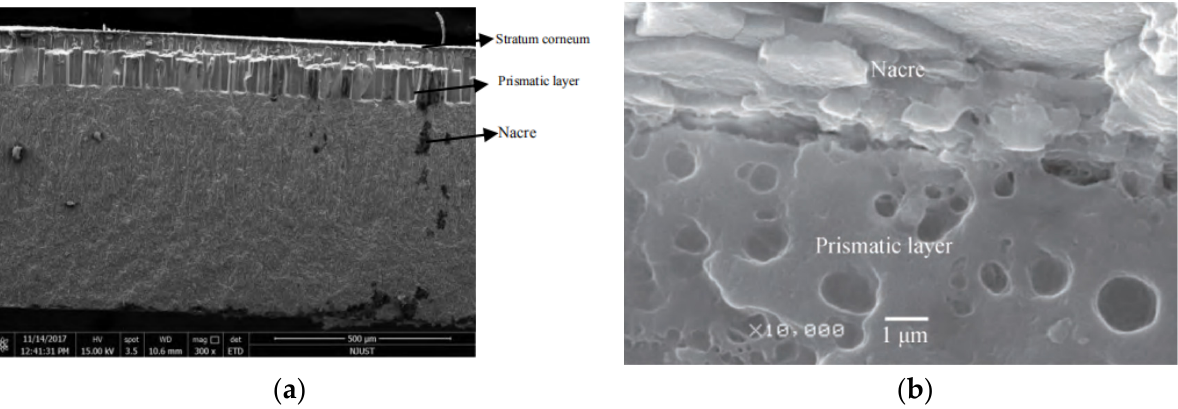
Figure 1. Microstructure of Hyriopsis cumingii seashell. ( a ) Distribution of seashell structure layer; ( b ) Distribution of holes in the seashell.